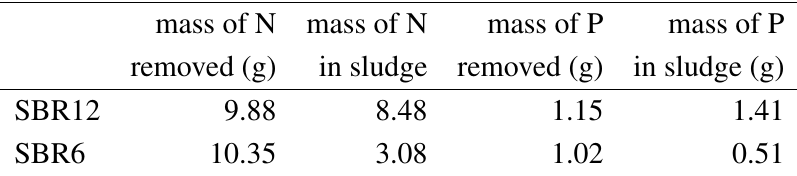
Table 4. Nutrient removal and calculated consumption by sludge